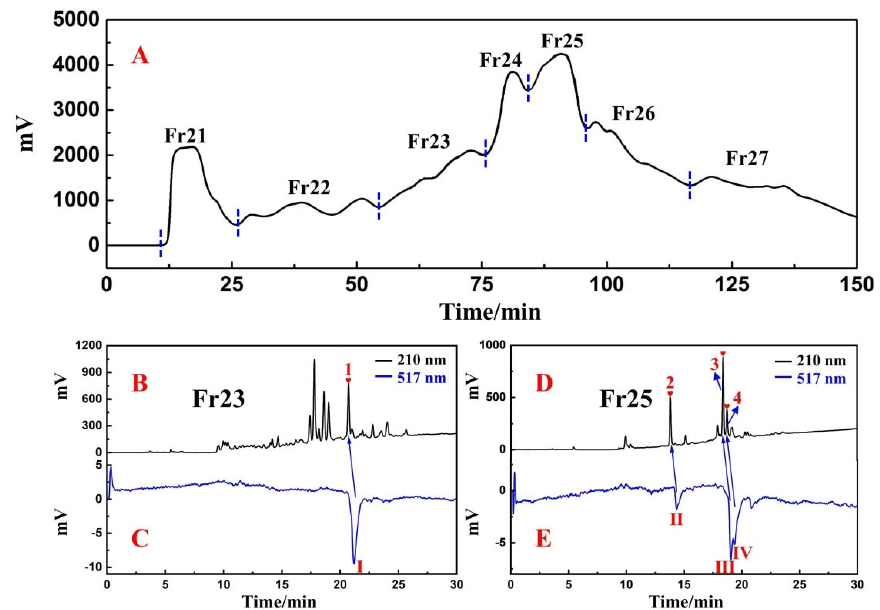
Figure 2. The pretreatment chromatogram ( A ) of Fr2 from D. heterophyllum with MCI GEL ® CHP20P middle ‐ pressure liquid chromatography. The analytical chromatograms of fractions Fr23 and Fr25 on a Click XIon analytical column ( B , D , respectively), acquired at a wavelength of 210 nm. The HPLC was performed at a flow rate of 1.0 mL/min, using a column temperature of 30 °C, with 0.1% v / v trifluoroacetic acid in water and acetonitrile (ACN) as mobile phases A and B, respectively, and with a gradient of 0–30 min using 100–60% B. Scavenging profile of 1,1 ‐ diphenyl ‐ 2 ‐ picrylhydrazyl (DPPH) radical for fractions Fr23 and Fr25 ( C , E , respectively), acquired at 517 nm while using a flow rate of 0.8 mL/min for the DPPH solution. The negative peaks I ‐ IV correspond to active peaks 1 ‐ 4, respectively.